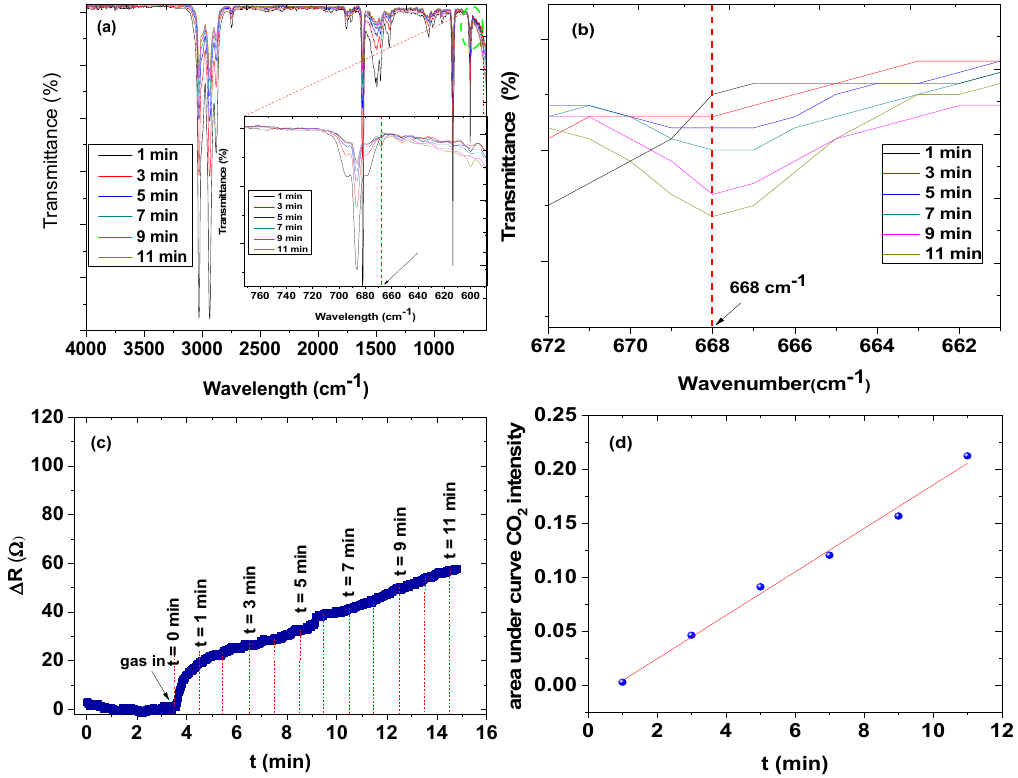
Figure 13. The in situ FTIR of mesitylene ( a ) the in situ FTIR CO 2 bands in a narrow range ( b ), the mesitylene vapor response curve online with the FTIR ( c ), and the areas under the curve of the CO 2 IR intensities against time (min) ( d ).